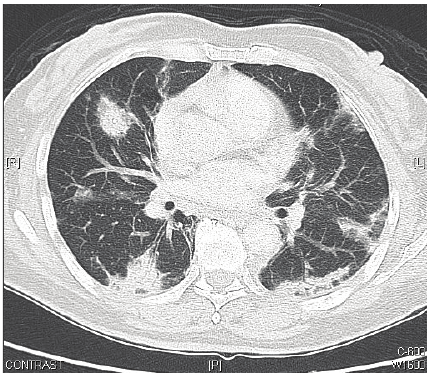
Figure 1: High-resolution computed tomography scans show peri- bronchial and subpleural bilateral ground-glass opacities with air bronchograms, some with pleural-based triangular shape.